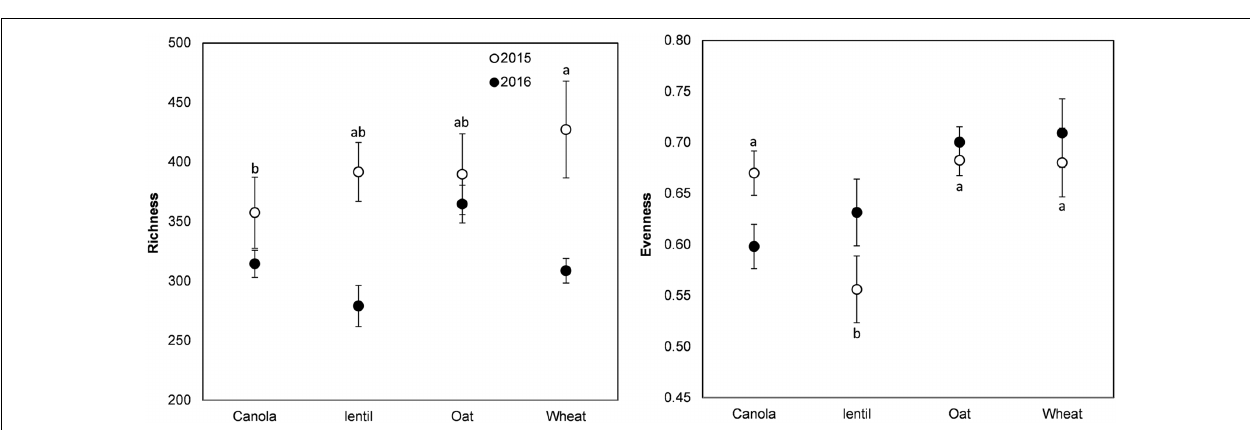
FIGURE 4 | Variation (mean ± SE) of the richness (Chao1 index) and evenness (Pielou’s index) of the fungal community of pea rhizosphere as influenced by previous crops in 2015 and 2016. Year influenced richness ( P < 0.001), but previous crops had no significant effect. Previous crops influenced evenness in 2015. Error bars with different letters indicate a significant difference at P < 0.05, according to Tukey